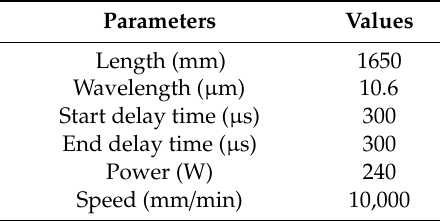
Table 2. Parameters of the laser bleaching.